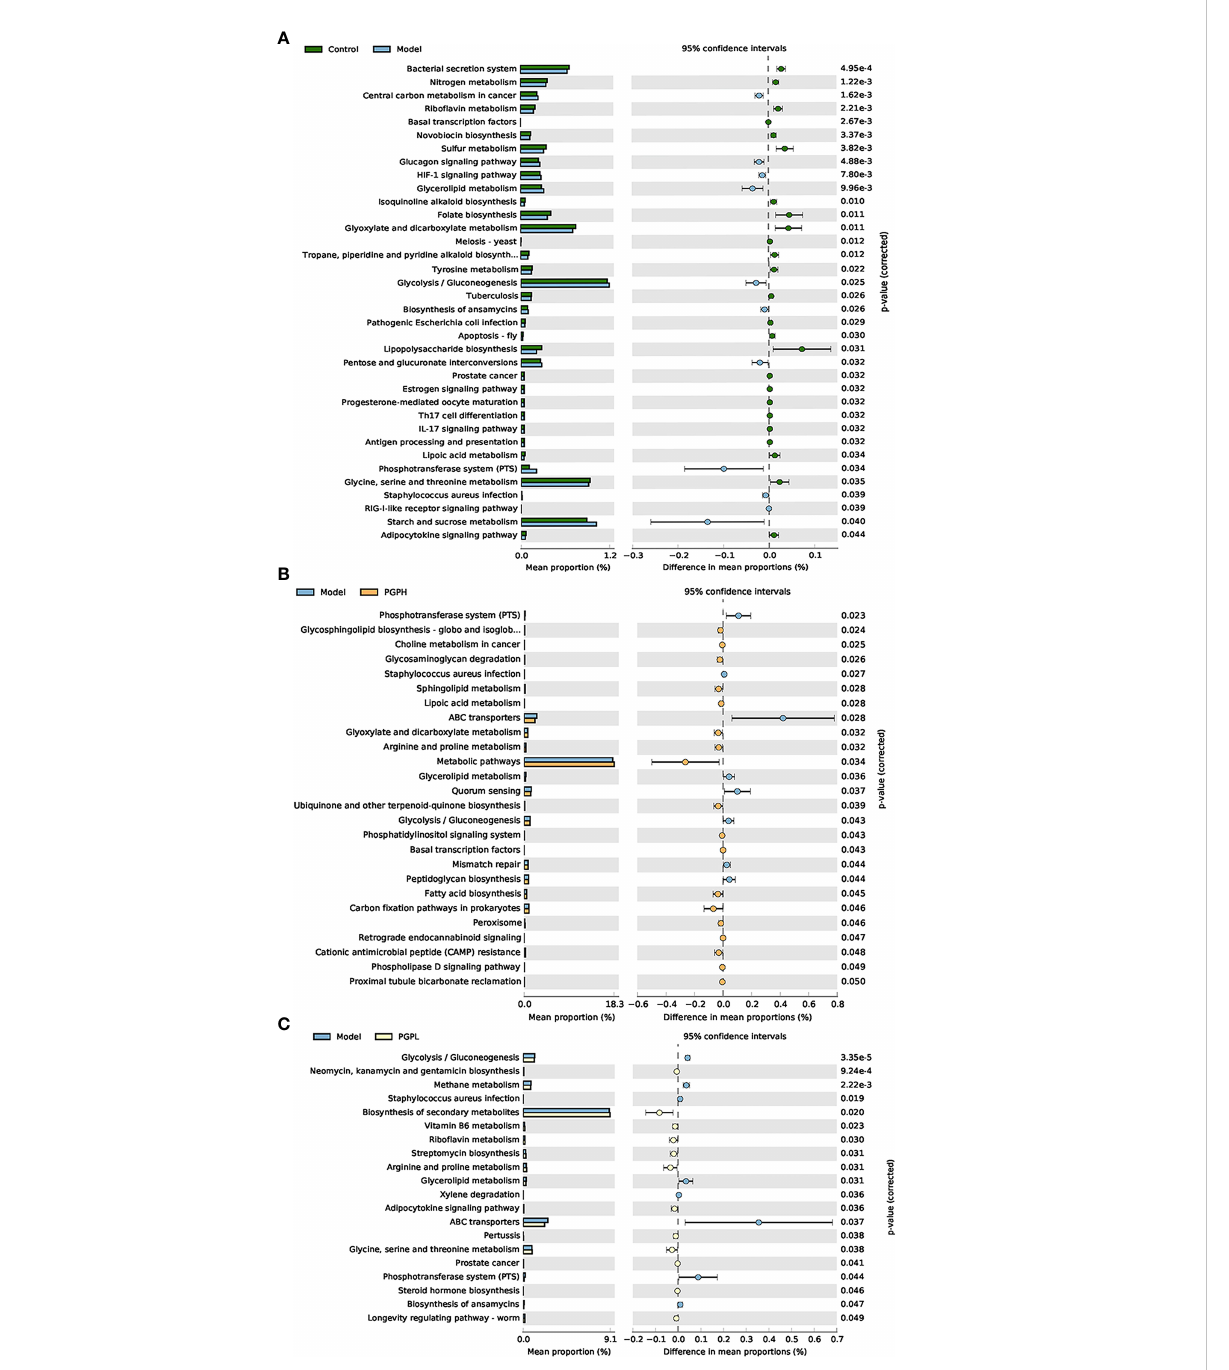
FIGURE 8 Functional prediction of altered gut microbiota, based on Kyoto Encyclopedia of Genes and Genomes pathways using the phylogenetic investigation of communities by reconstruction of unobserved states analysis. (A) Control group versus model group; (B) model group versus PGP-H group; (C) model group versus PGP-L